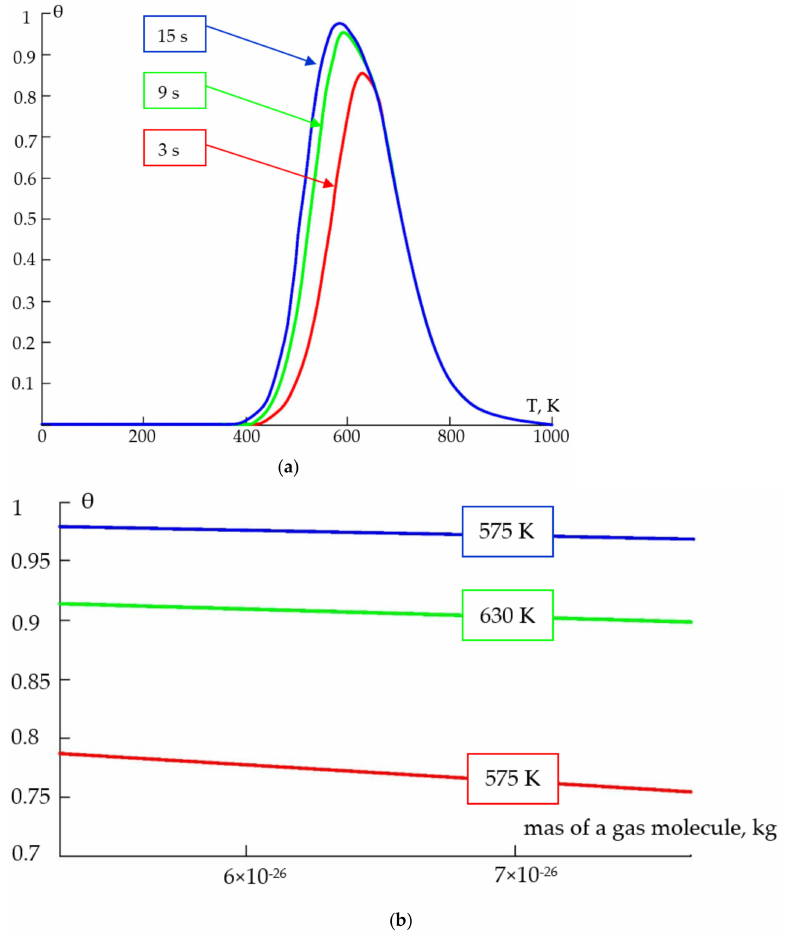
Figure 19. The dependence of degree of filling on temperature at different filling times ( a ); mass of a gas molecule at different temperatures ( b